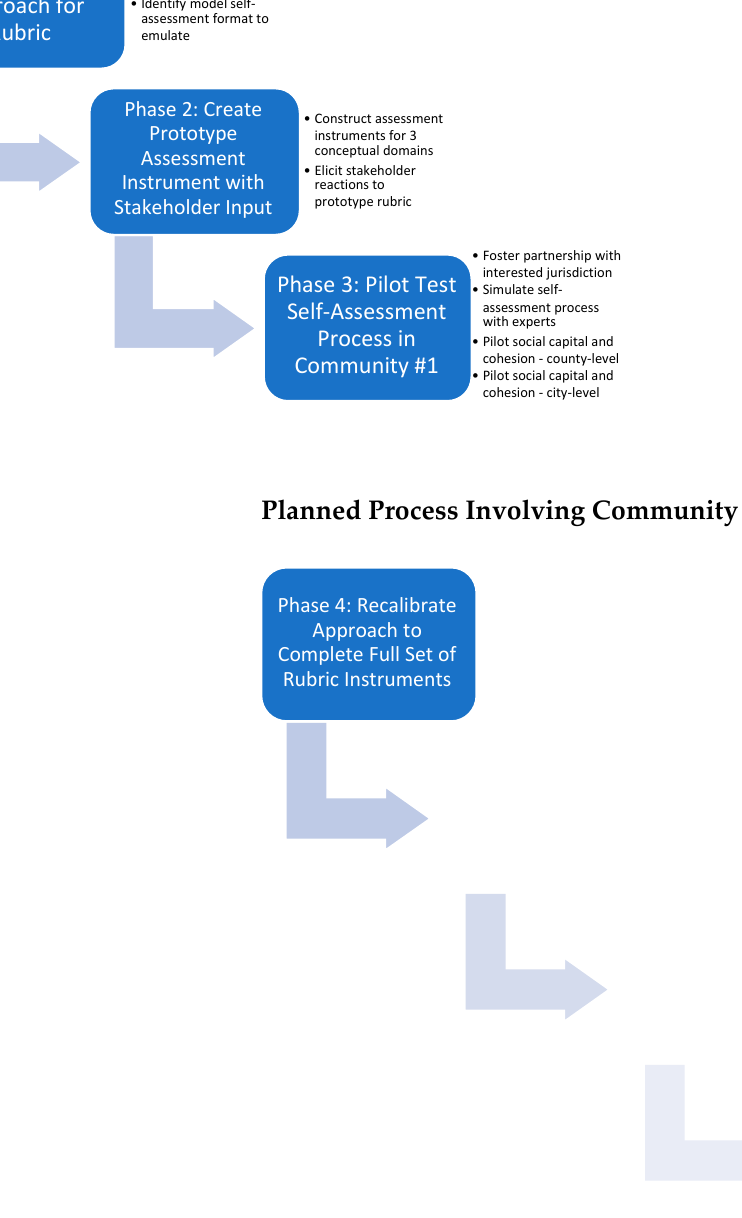
Figure 2. COPEWELL Rubric Co-Development